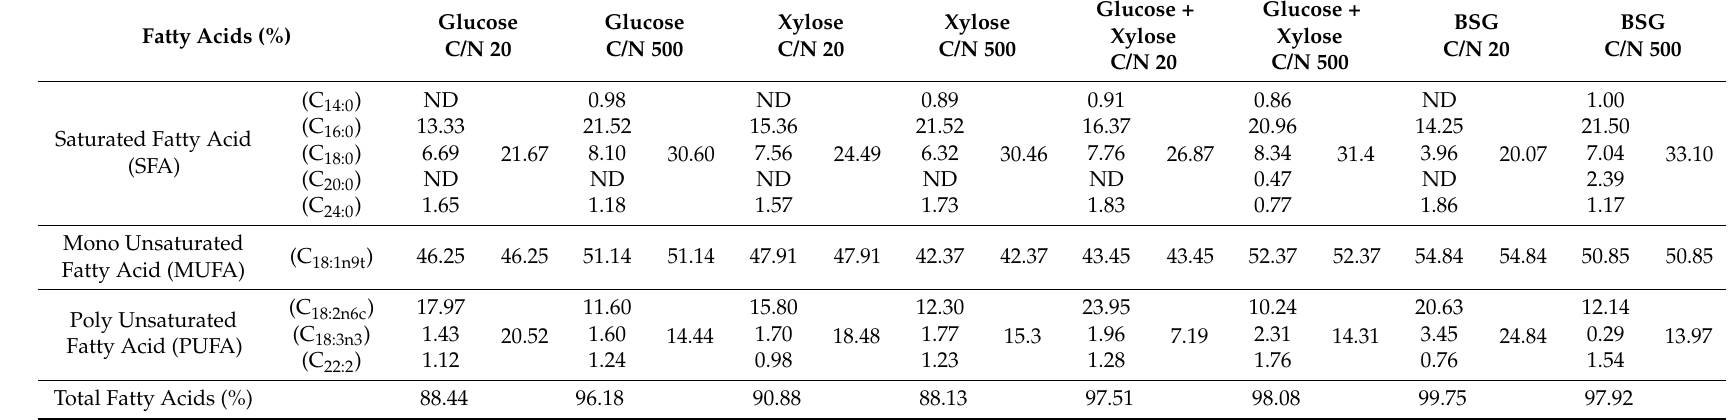
Table 2. Fatty acids of corresponding FAME (fatty acid methyl ester) profiles obtained after transesterification of lipids extracted from oleaginous yeast grown on various substrates.